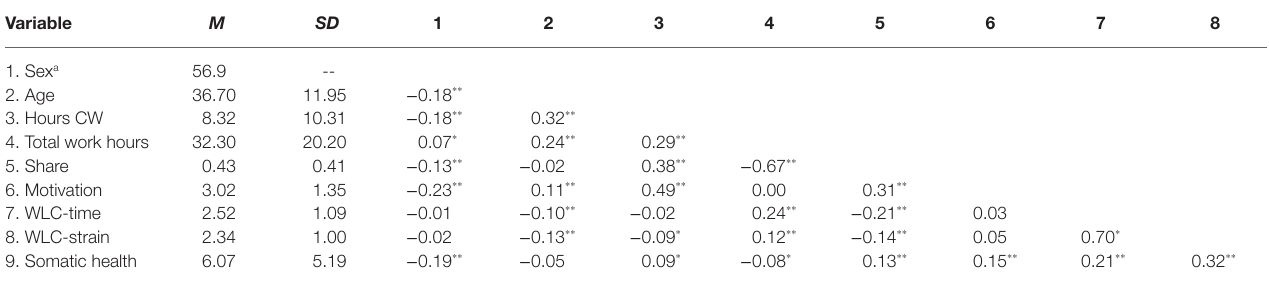
TABLE 2 | Correlations of study variables. Variable